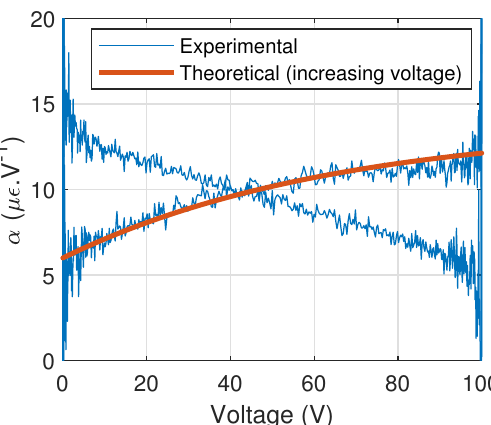
Figure 7. Low frequency characterization. Theoretical plot has been obtained using Equation (10).